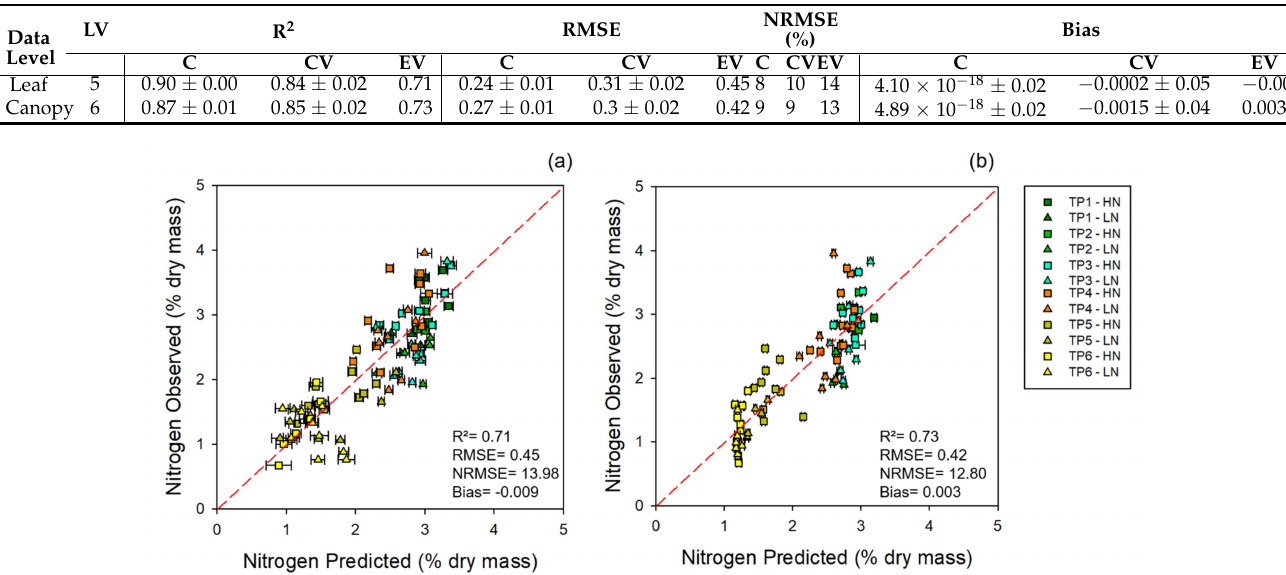
Table 1. Performance metrics of the 2017 model: number of latent variables (LVs), goodness of fit ( R 2 ), root-mean-square error (RMSE), normalized root-mean-square error (NRMSE), and bias for calibration (C), cross-validation (CV), and external validation (EV). Data generated via cross-validation using 500 random permutations of the dataset with 70% of the total data divided into 80:20 split for C and CV, respectively, for models predicting nitrogen concentrations from wheat foliage using hyperspectral data. EV was generated by applying coefficients generated in the C:CV approach to the 30% of the data excluded from the C:CV approach. Data shown as mean ± standard deviation.